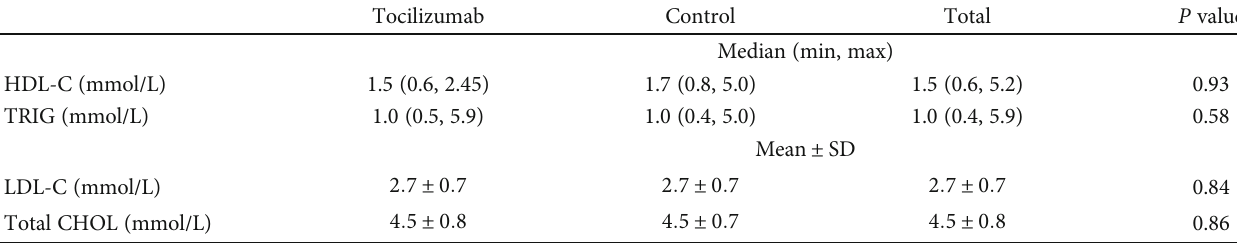
Table 4: Clinical characteristics at baseline: lipid pro fi le.